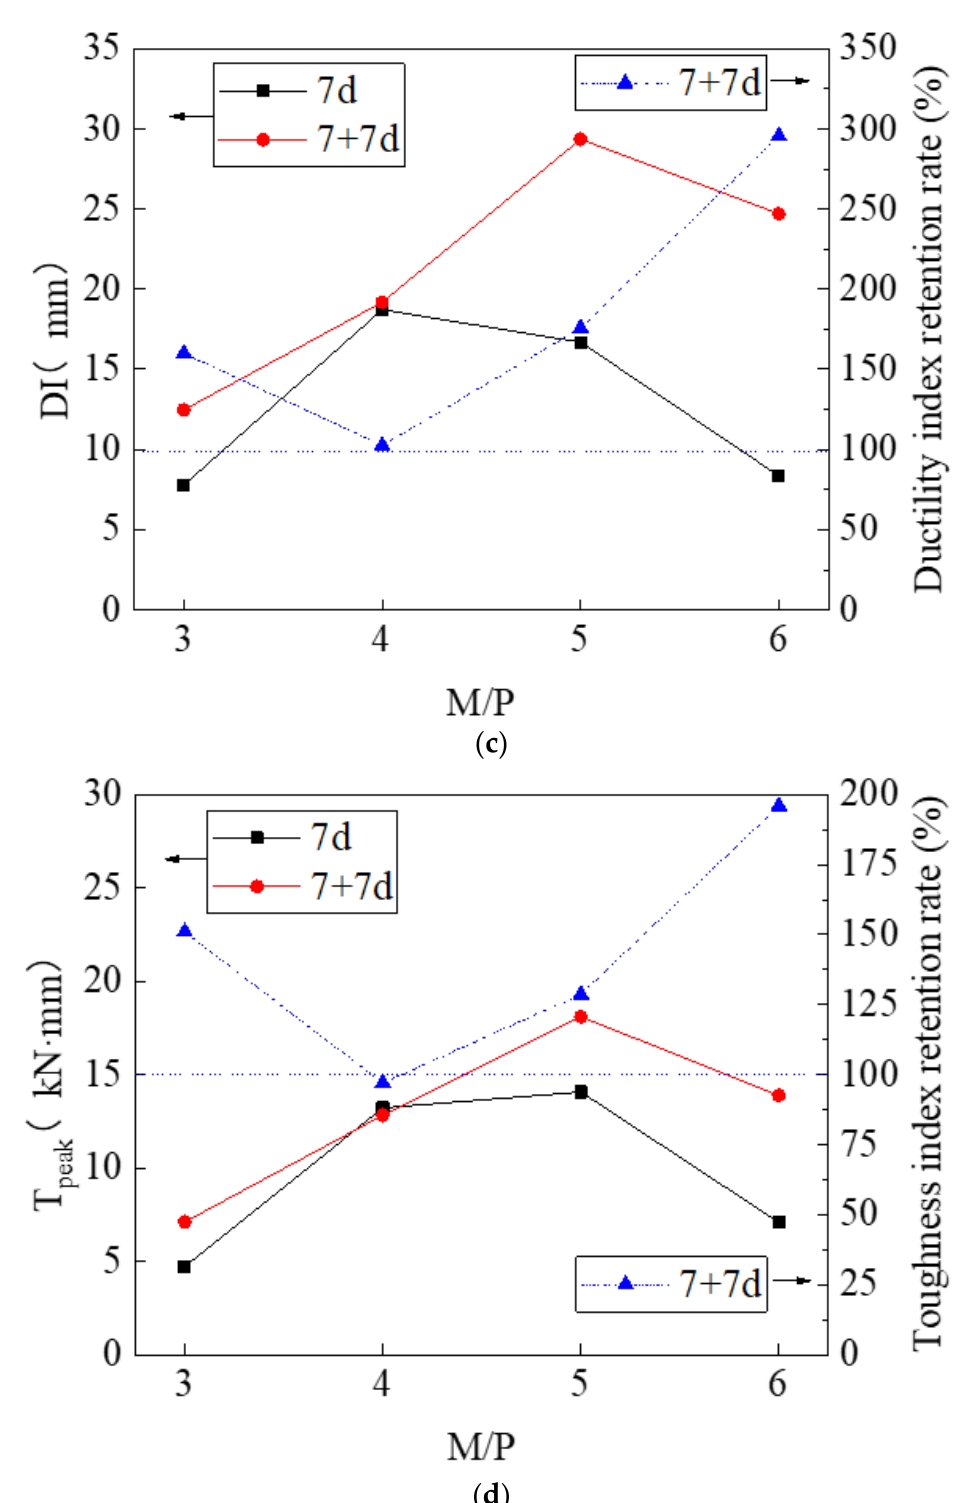
Figure 11. ( a ) First-crack strength, ( b ) ultimate flexural strength, ( c ) ductility index, and ( d ) toughness index, together with their retention rates, of HDMC with different M/P ratios.